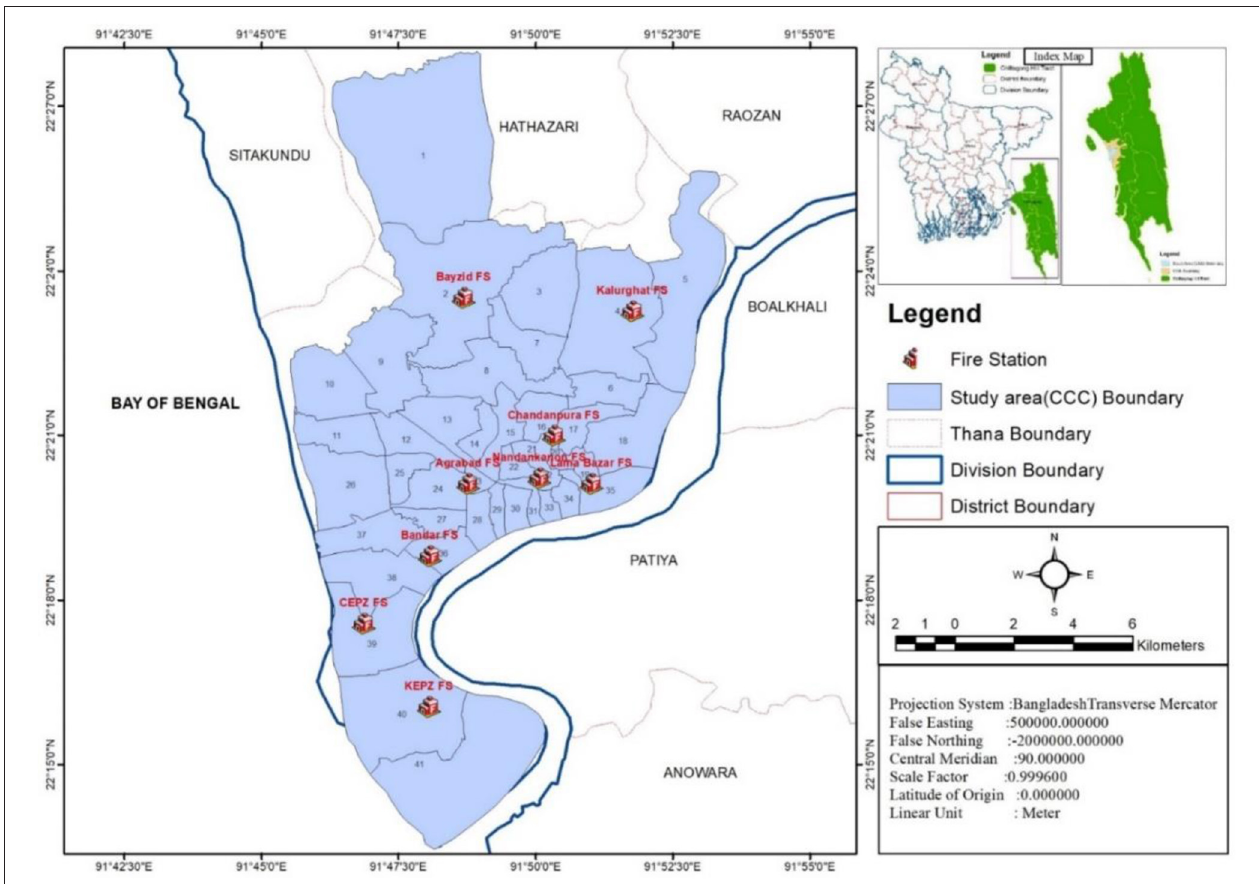
FIGURE 1 | Location of study area (Chattogram City Corporation